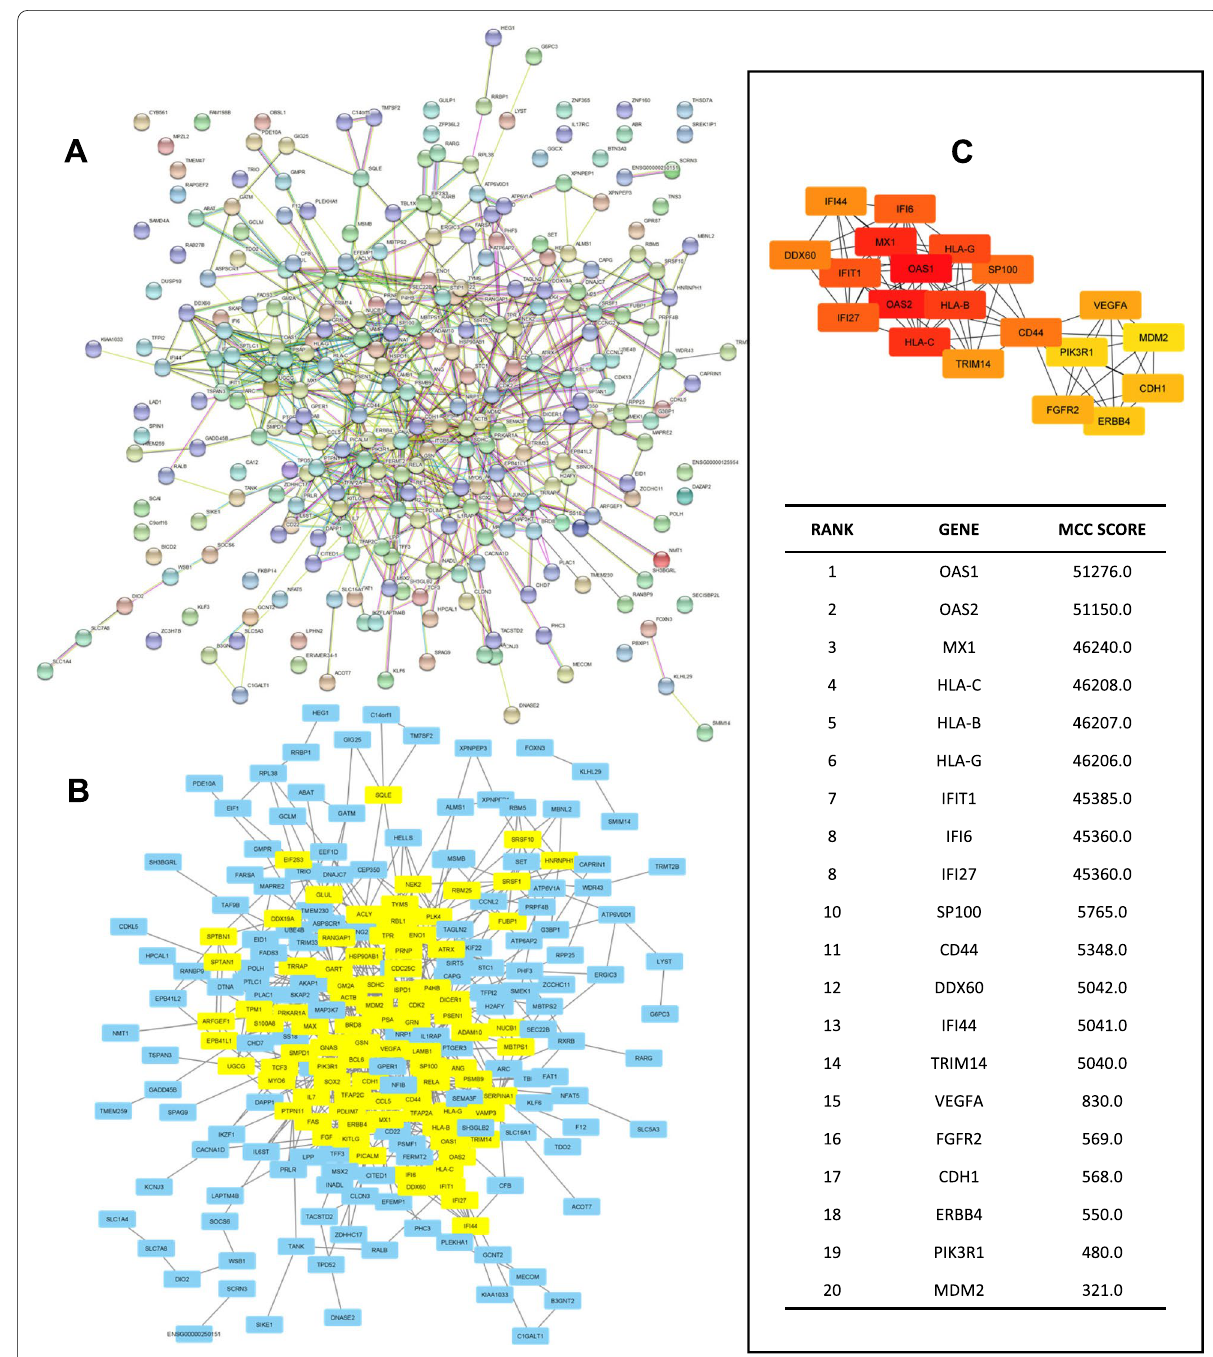
Fig. 3 Interactions between proteins encoded by OTGs. A STRING-DB analysis of the PPI network of proteins involved in overcoming tamoxifen resistance by OA. B The PPI filtered results subjected to Cytoscape 3.8.0 to filter out proteins with a value of 5° or more, which are shown in yellow. C Top 20 hub genes with the highest MCC score analyzed using the CytoHubba